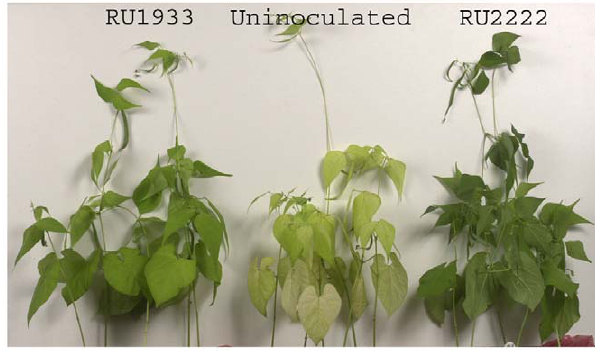
Figure 1. Growth of beans infected by different strains of R. leguminosarum bv. phaseoli . Plants were inoculated with RU2222 (wild-type), RU1933 ( aapJQM :: V Sp braE ::Tn phoA ) or left uninoculated.